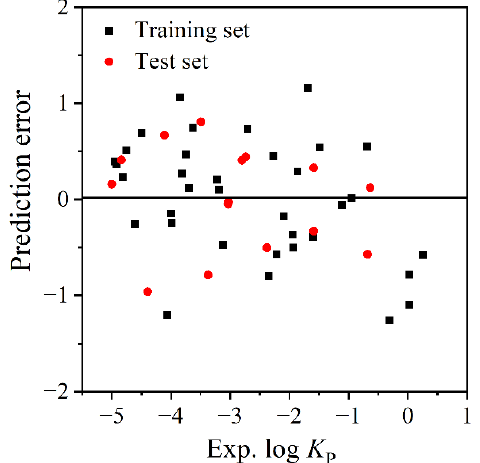
Figure 3. The distribution of predictive log K P errors by MLR model.